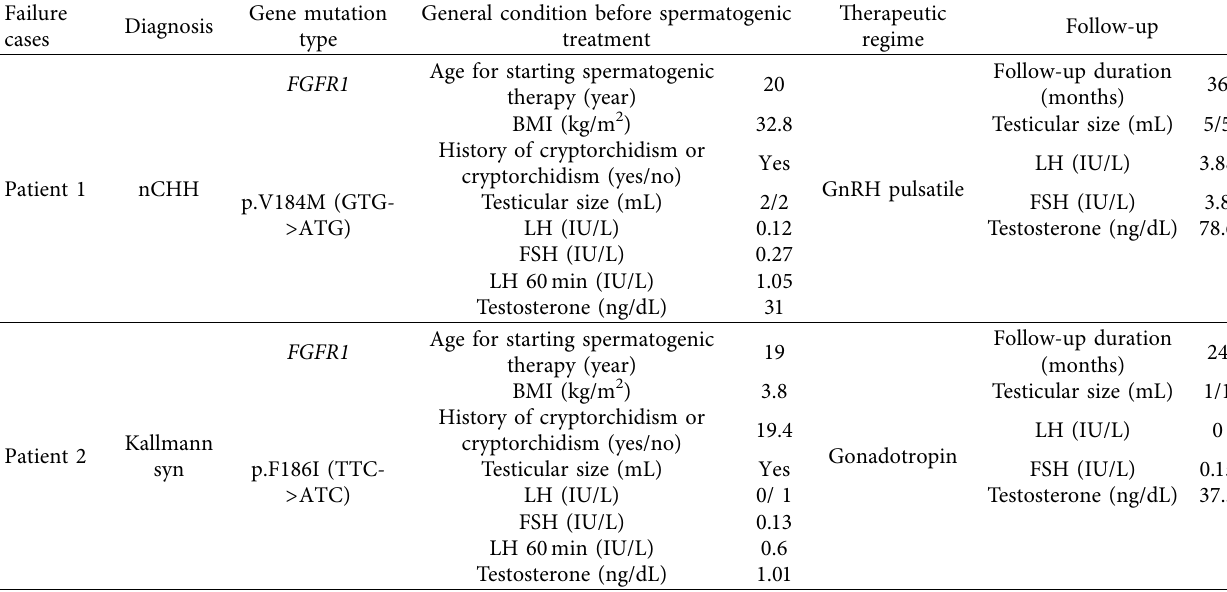
Figure 3: Sperm parameters (ejaculate volume and concentration) after spermatogenesis treatment (the plot was described as median with interquartile range). Table 5: Clinical manifestations and hormone levels in patients who had a failure of